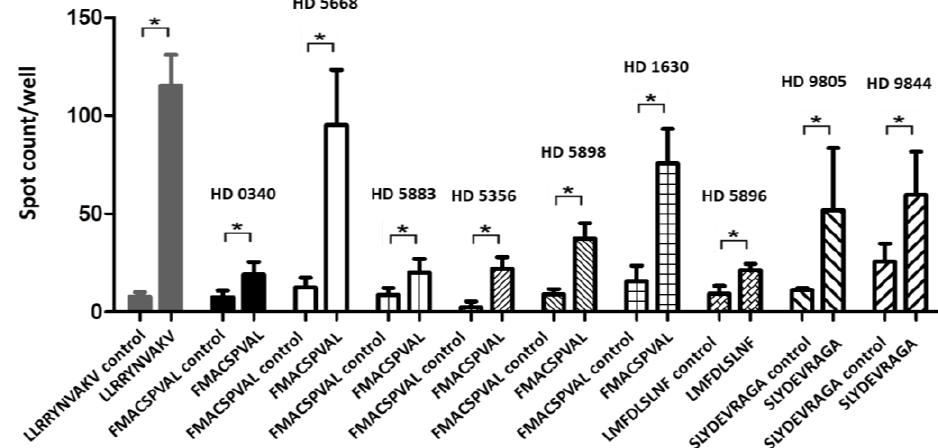
Figure 4. Summary of the positive peptide-specific T cell responses detected by IFN- γ ELISPOT for each healthy donor (HD). This figure shows only the positive responses of LLRRYNVAKV, FMACSPVAL, LMFDLSLNF, and SLYDEVRAGA peptide-specific T cells after a co-culture with T2 cells loaded with the respective peptides. Peptide-specific T cells co-cultured with unloaded T2 cells were considered as a negative control. The spots were counted, and the results were considered positive when the spot count was at least twice as high as that of the negative control. Mean values were calculated for each group; error bars indicate SD. Statistical significance was calculated using a paired-sample t -test and is indicated by * for p values < 0.05.